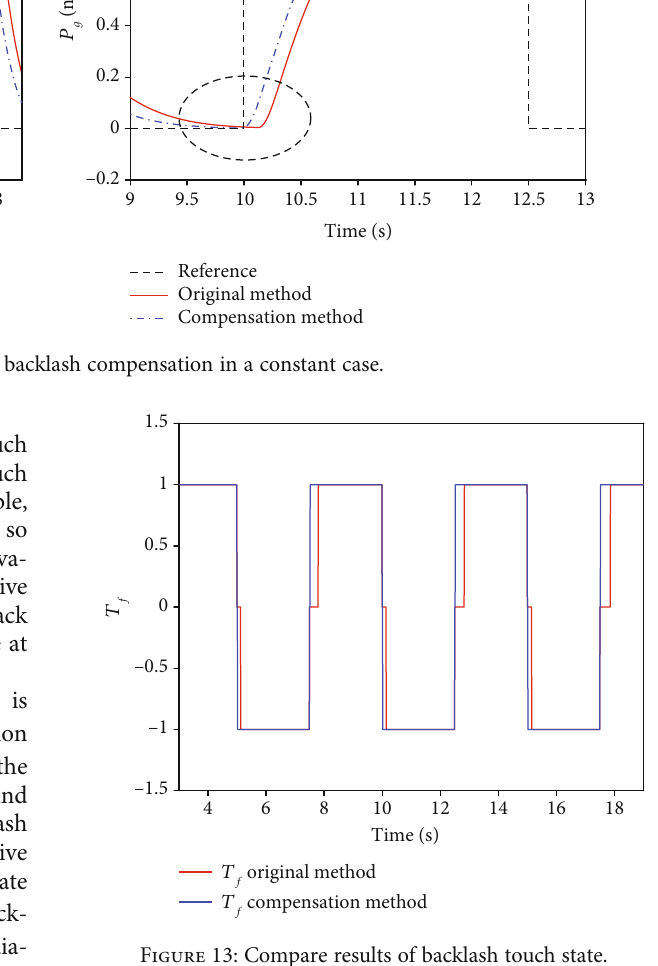
Figure 13: Compare results of backlash touch